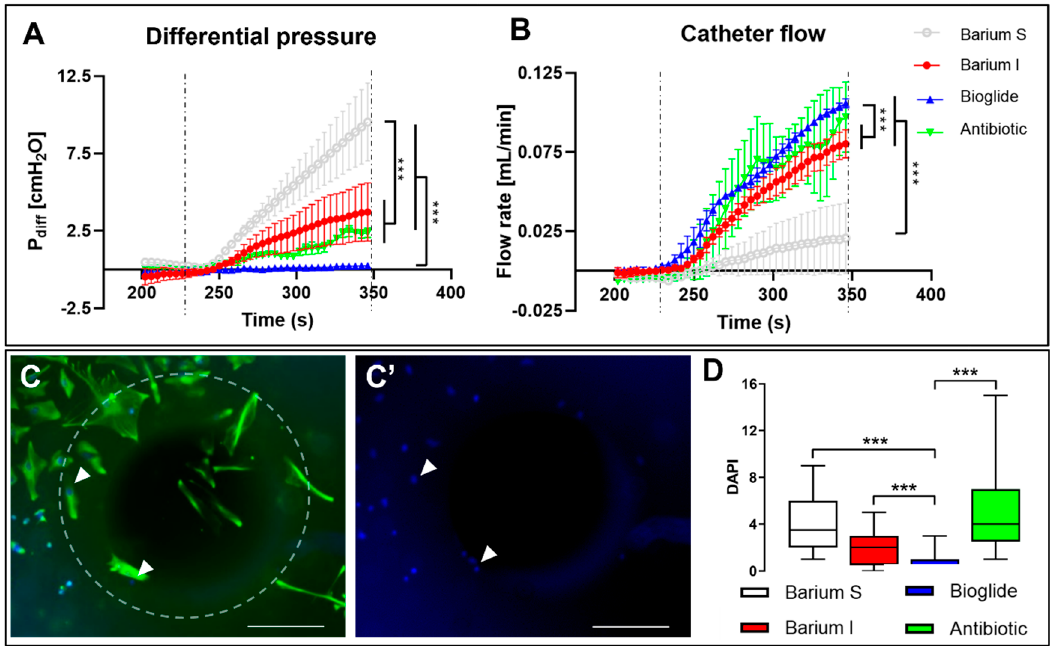
Figure 4. Catheter performance under obstructive conditions. ( A ); Graphic representation of intracranial-like pressure associated with astrocytic growth within commercial catheters. Significant pressure differences were found between all catheter types (*** p < 0.001), excluding the comparison between Barium I and antibiotic-impregnated catheters. Barium S demonstrated the highest pressure, and bioglide demonstrated the lowest pressure. ( B ); Graphic representation of flow associated with astrocytic growth into commercial catheters. Significant flow differences were found between all catheter types (*** p < 0.001) for the comparison between Barium I and antibiotic-impregnated catheters. Barium S exhibited the lowest flow, and Bioglide exhibited the highest flow (*** p < 0.001). Dashed lines indicate pump on and off time points. Data were obtained from 5 catheters per condition. Results were analyzed with the Friedman test. C & D; Immunocytochemistry against GFAP to label astrocytes and DAPI ( C ) to label nuclei (arrowhead). Cellular adhesion was quantified using DAPI ( C’ ). ( D ); Graphical representation of cellular adhesion in all catheter types, indicating significantly less adhesion in Bioglide catheters (*** p < 0.001). Data included n = 20 values per condition and were analyzed with the nonparametric Mann–Whitney U-test. Barium S, barium stripe; Barium I, barium impregnated; Bioglide, Bioglide impregnated; Antibiotic, antibiotic-impregnated. Scale bars: 100 µm.